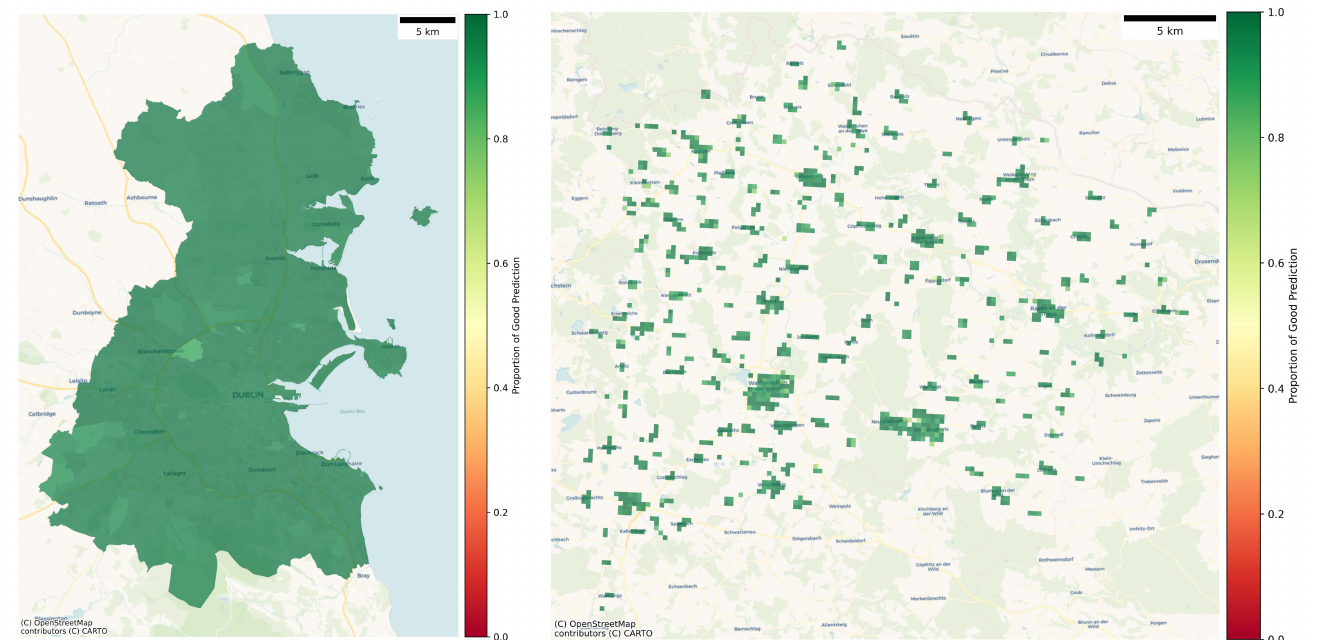
Figure 3. Spatial distribution of the PGP for Dublin ( left ) and Waidhofen an der Thaya ( right ). However, Figure 4 indicates a significantly larger share of areas with a lower PGP and also a lower median value for the Waidhofen case study compared to the Dublin case. This may be due to the larger number of reference data points for calculating the PGP as well as the significantly lower number of buildings per area in Waidhofen compared to the Dublin case. Both of these aspects make the generation of the synthetic building stock more complex and therefore harder to match the distribution in the reference data.